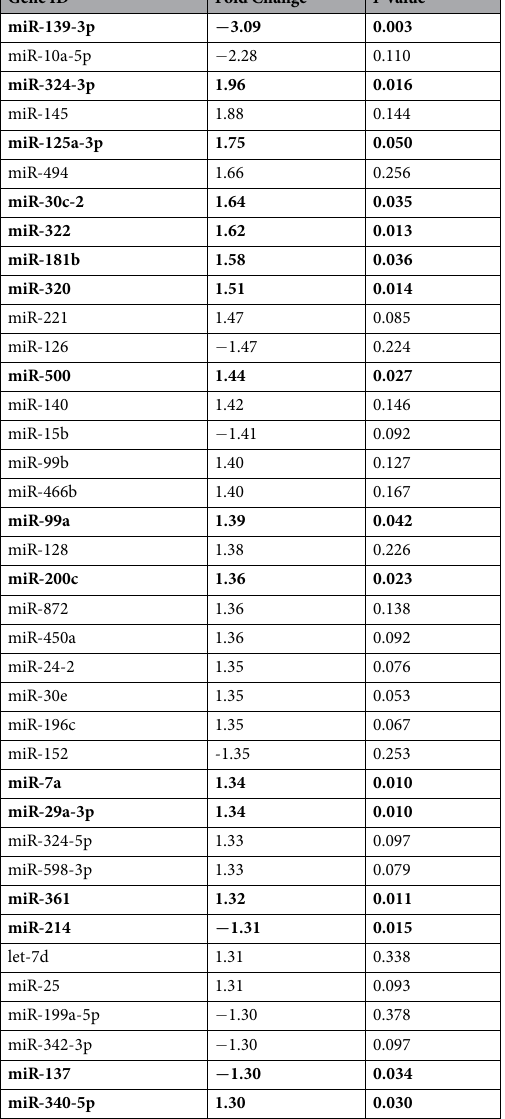
Table 2. miRNAs identified to be dysregulated. List of expressed miRNAs defined as dysregulated in miRNA microarray analysis in the Ucn-1 group as compared with the I/R group. miRNAs are classified by higher rate of change in Ucn-1 treatment versus untreated I/R. Expressed miRNAs are filtered based on “Fold change > 1.3 or <− 1.3”. Bold letters is for miRNAs with significant changes at p < 0.05. I/R, ischemia/reperfusion; Ucn-1 (10 nM) was applied 5 minutes before